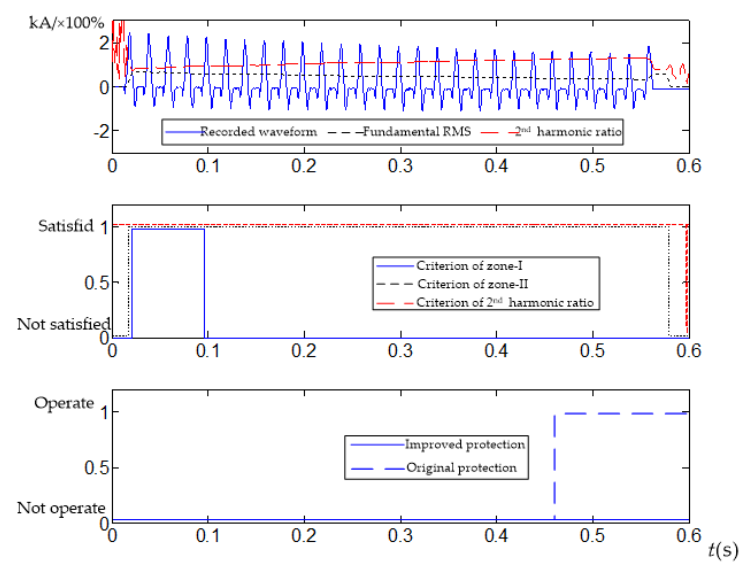
Figure 13. Protection behavior of waveform Number Two 1 .